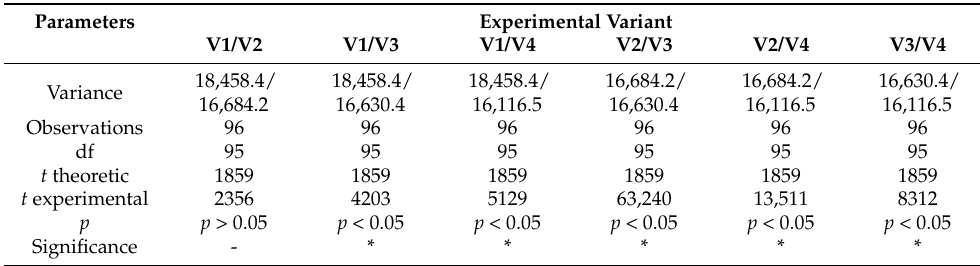
Table 6. Result summary of two-way t significance tests between four variants of experimental plot for